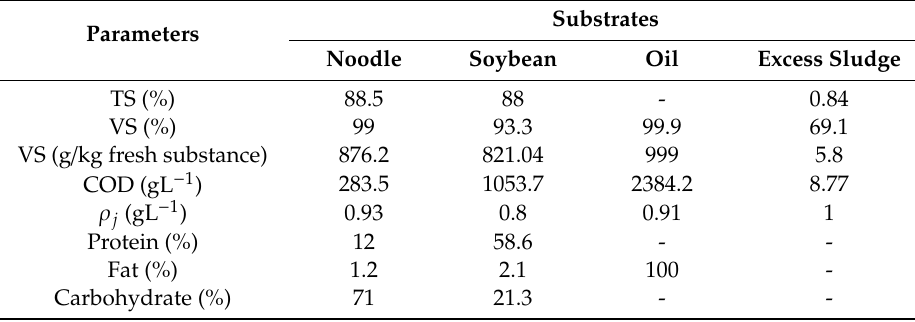
Table 1. Composition of the used feeding